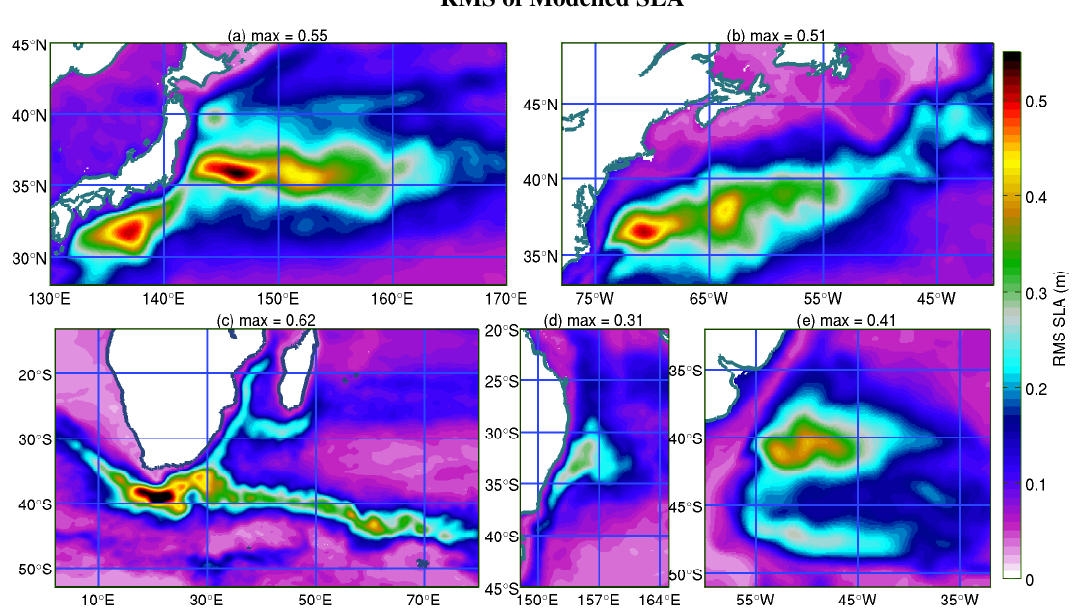
Fig. 10. RMS modelled SLA for the (a) Kuroshio, (b) Gulf Stream, (c) Agulhas, (d) EAC, and the (e) BMC region. The color scheme is different for different regions according to the inserted legend.